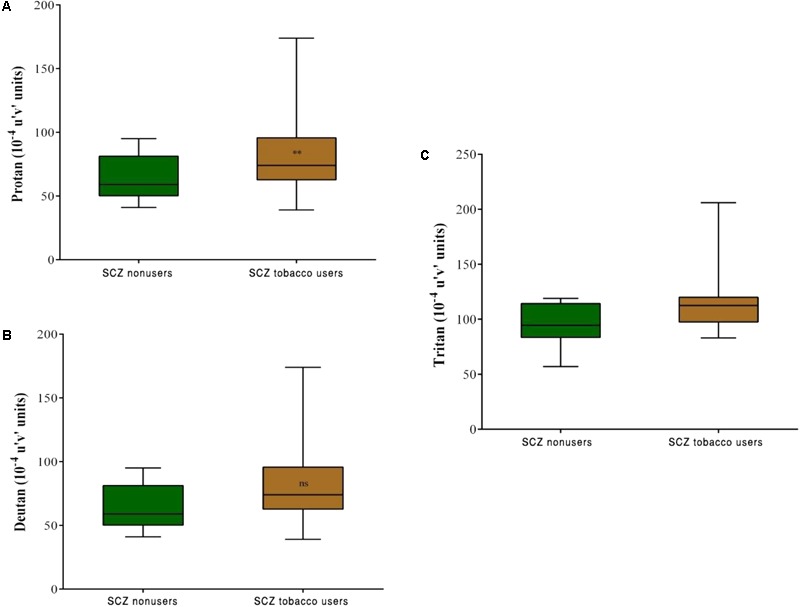
Trivector test, showing boxplots for protan (A), deutan (B), and tritan (C) confusion lines. The data are presented in 10-4 u’v’ units. Each boxplot is based on the results of 20 participants. ∗∗p < 0.01.